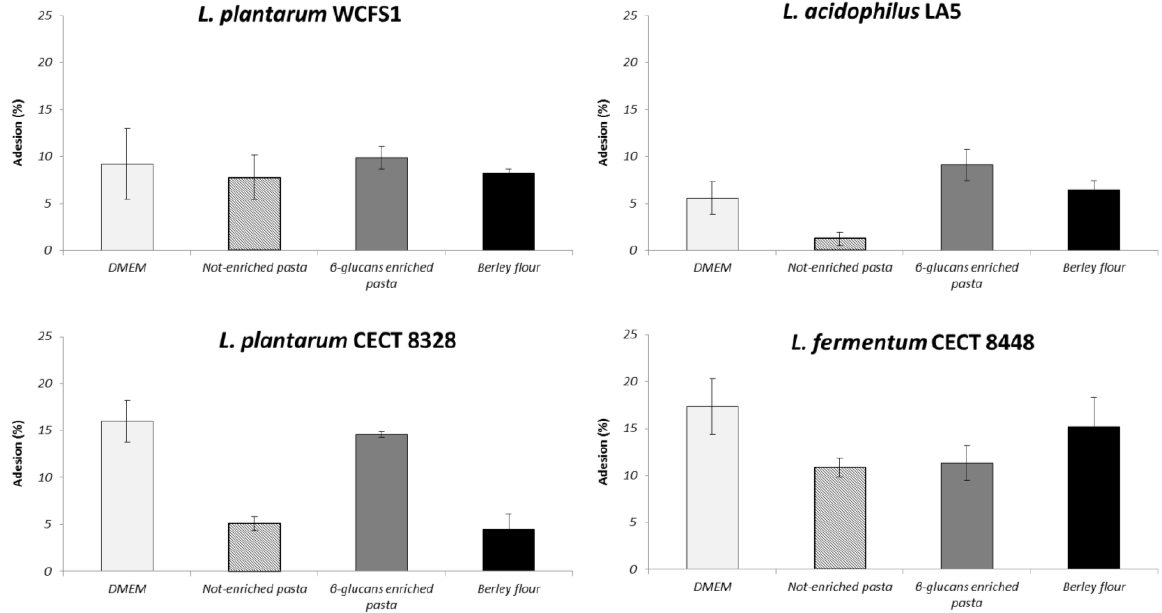
Figure 4. Adhesion of L. plantarum WCFS1, L. acidophilus LA5, L. plantarum CETC 8328 and L. fermentum CECT 8448 to Caco-2 cells in the presence of DMEM medium (positive control), not-enriched pasta, β-glucans enriched pasta and barley flour. Values represent mean ± standard deviation of three different